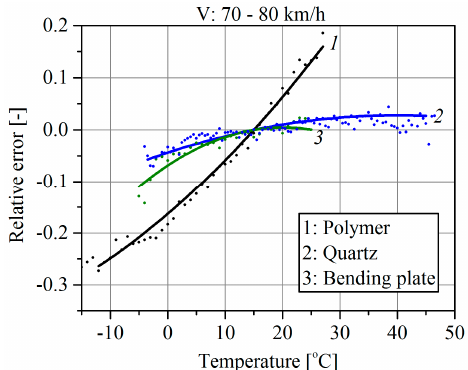
Figure 3. Comparison of temperature characteristics of polymer, quartz and bending plate sensors installed in pavement.